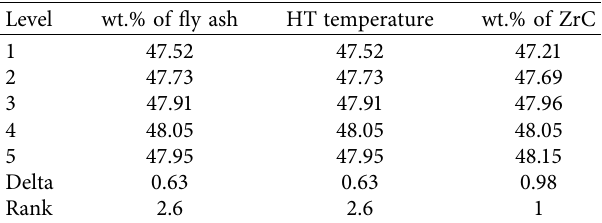
Table 5: Signal-to-noise (S/N) ratios response for UTS. Level